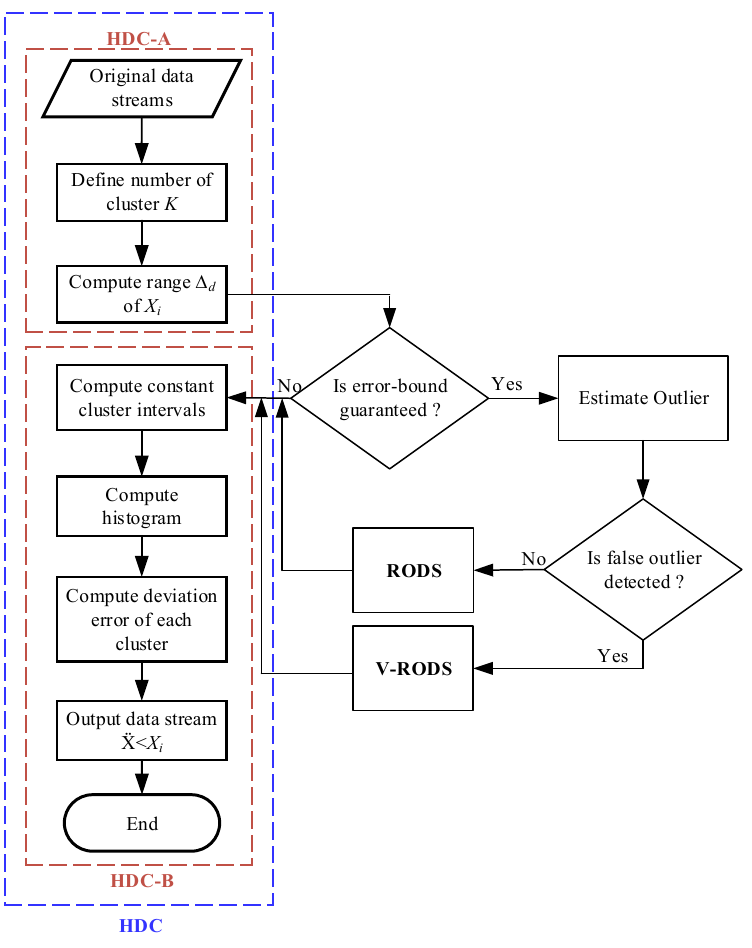
Figure 5. Execution flowchart of the proposed error-aware data clustering (EDC)